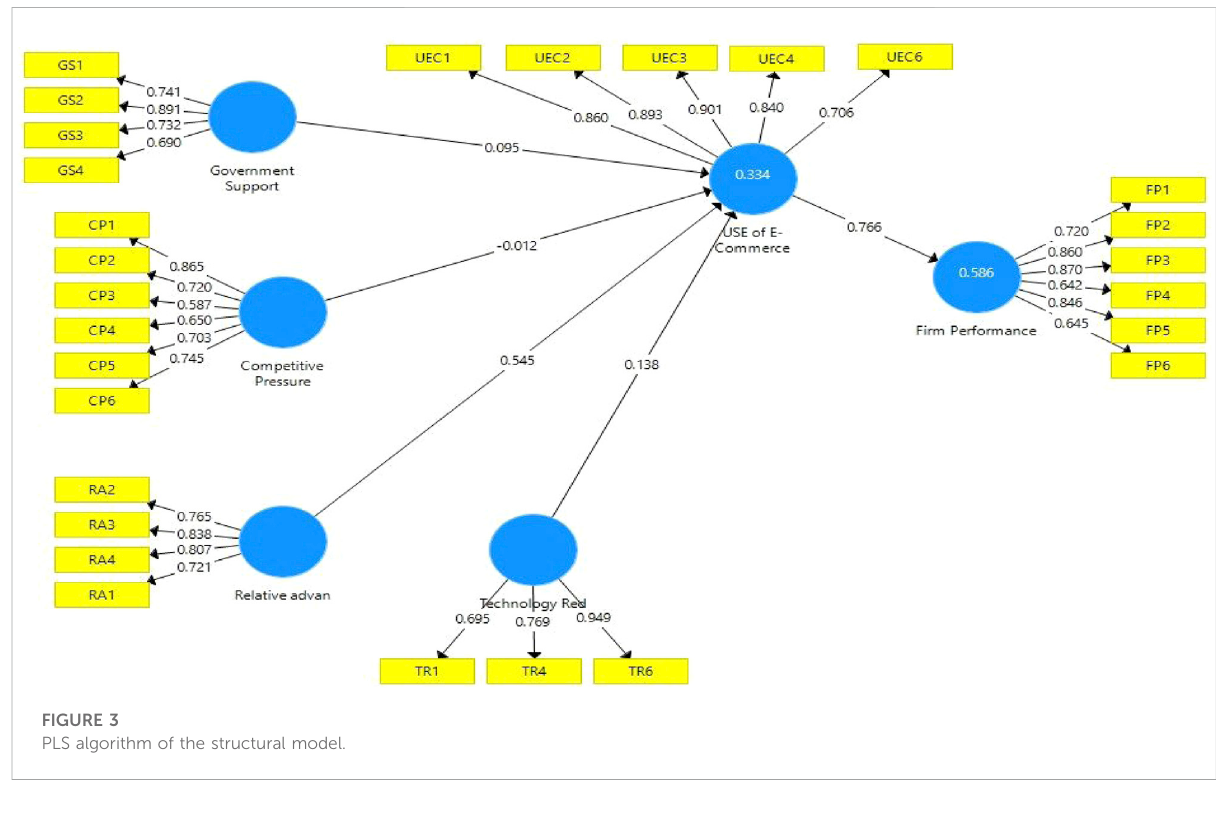
FIGURE 3 PLS algorithm of the structural model.